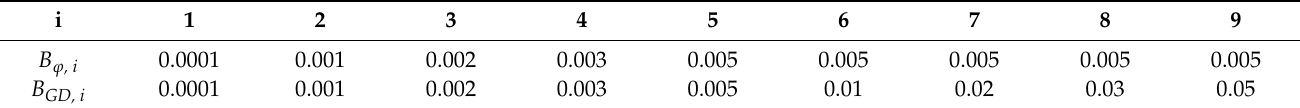
Table 2. Error factor values for each error